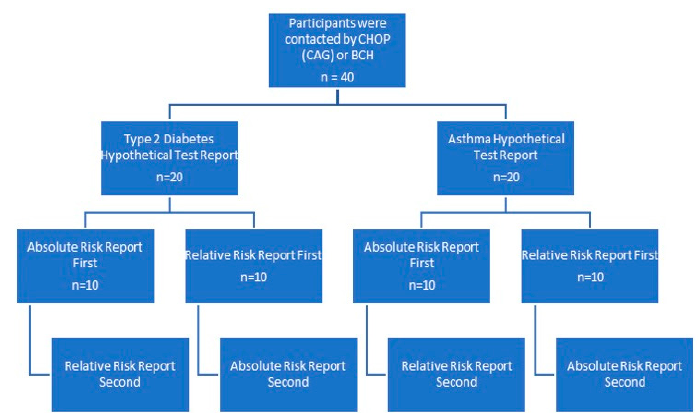
Figure 2. Workflow of conducted